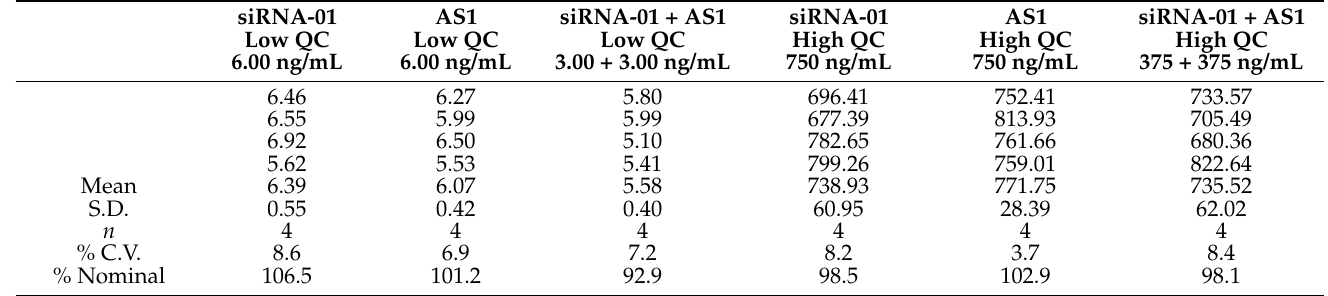
Table 2. Equivalence of the hybridization LC-MS/MS assay for the quantification of siRNA-01 and AS1. siRNA-01 Low QC